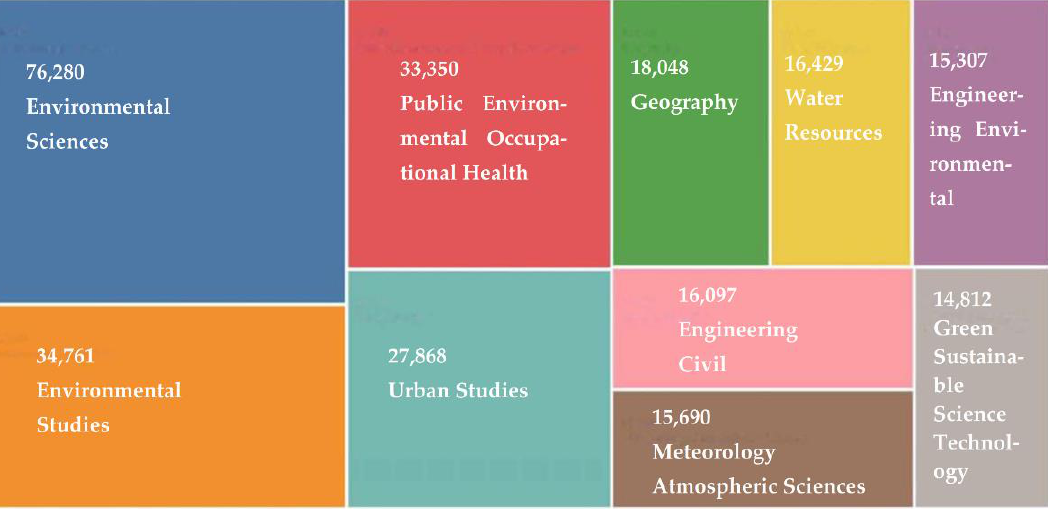
Figure 1. Results of the Meta-analysis of “Urban Studies” in the Web of Science Database (29 November 2022).